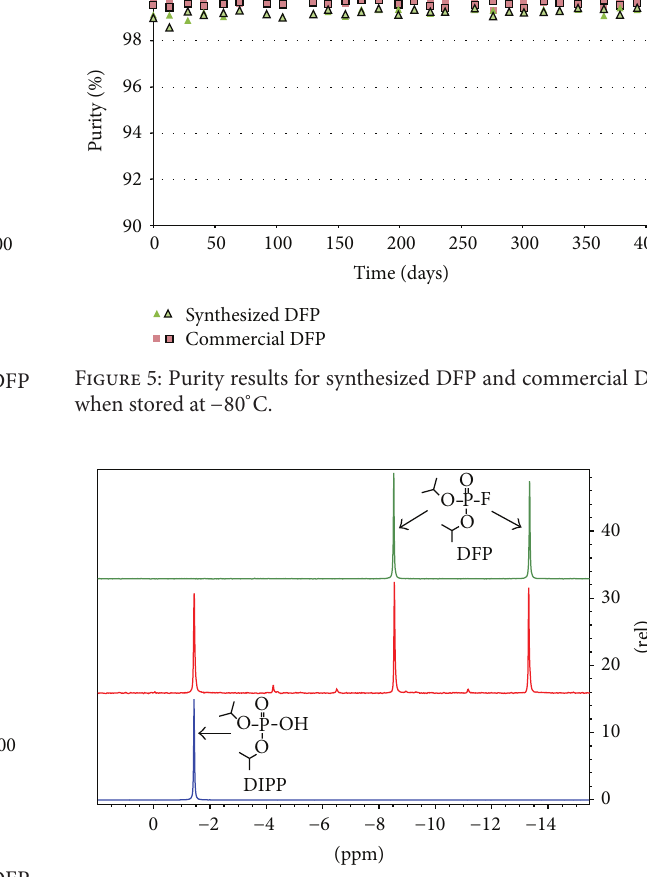
Figure 6: 31 P NMR spectra of pure DFP (top), partially degraded commercial DFP (middle), and a pure DIPP standard